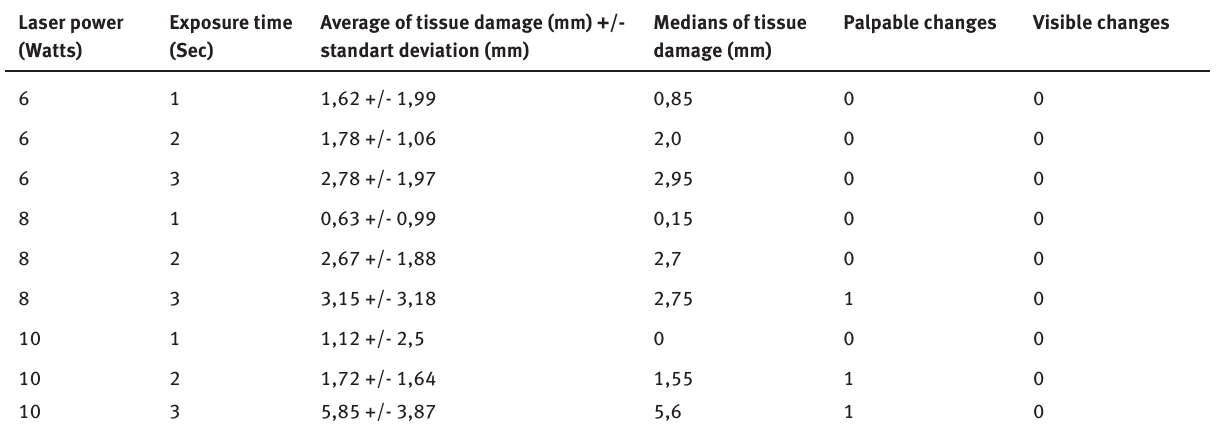
Table 1: Data of tissue damage, palpable and visual changes in different groups.